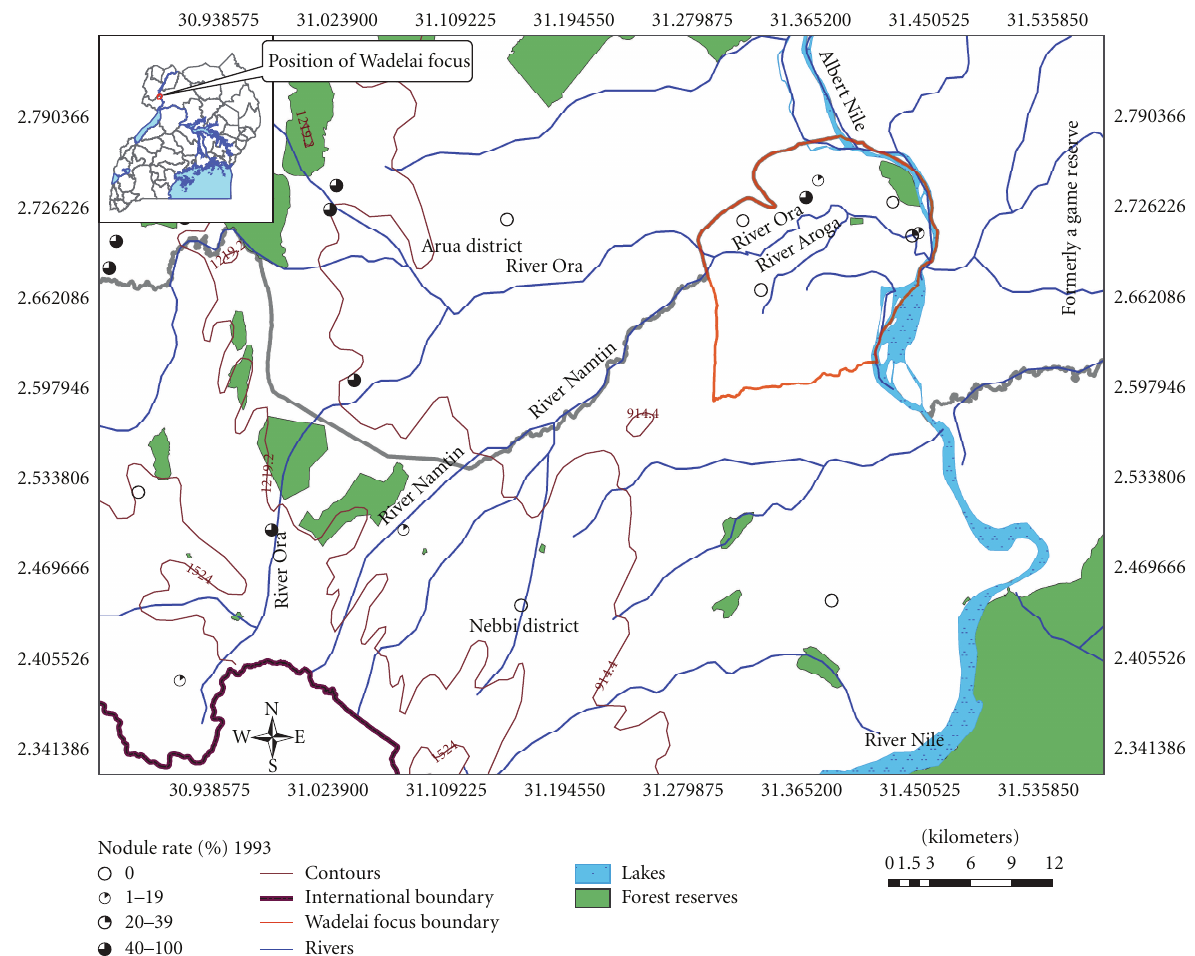
Figure 1: Wadelai focus 1993 rapid epidemiological assessment (REA) map of onchocerciaisis by nodule prevalence.